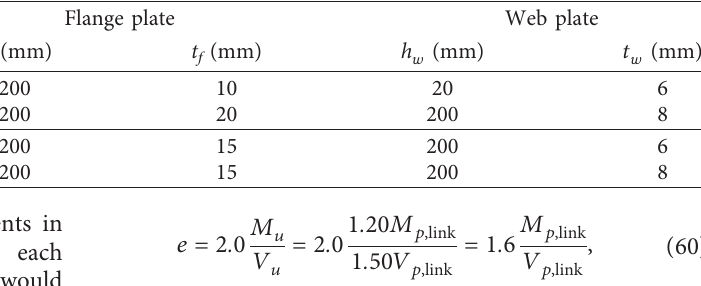
Table 1: Characteristics of used profile